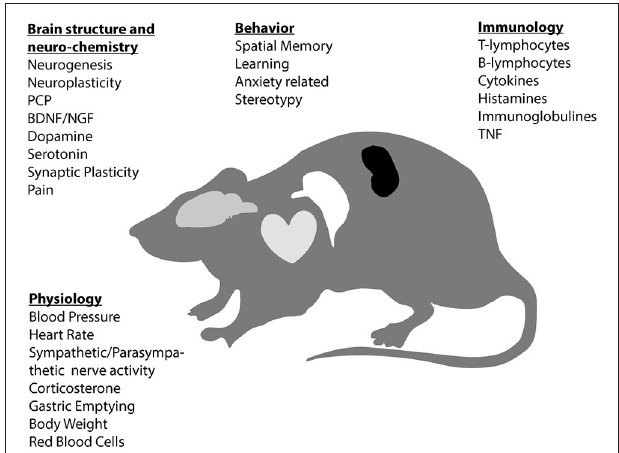
FIGURE 2 | Music affects different domains in rodents. PCP, precursor cell proliferation; BDNF, brain derived neurotrophic factor; NGF, nerve growth factor; TNF, tumor necrosis